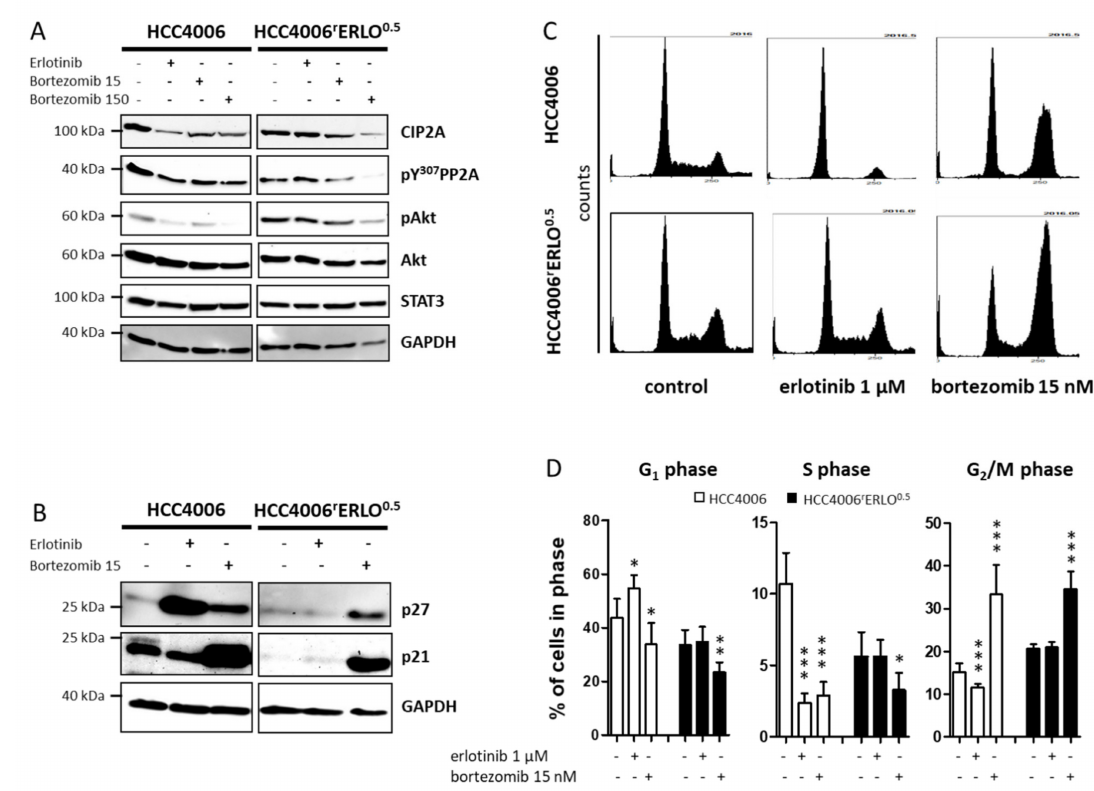
Figure 3. Bortezomib downmodulates cell proliferation regulating inhibitor of phosphatase 2A (CIP2A), restores regulation of Akt, and arrests cells in the G 2 /M phase of the cell cycle. Cells were incubated with 1 µ M erlotinib, 15 nM bortezomib ( A , B ) or 150 nM bortezomib ( A ) for 24 h. Proteins were separated on a 10% polyacrylamide gel and blotted on a nitrocellulose membrane, and specific target proteins were detected using target specific primary and species-specific secondary antibodies, coupled with horseradish peroxidase, as listed in the methods section. Signals were developed using a chemoluminescence substrate and detected with the ChemoCam System (Intas, Göttingen, Germany). A representative blot of at least three biological replicates is shown. ( C ) Distribution of the cell cycle phases was analyzed by propidium iodide staining of fixed cells and detection of the fluorescence intensities using a MACSQuant flow cytometer after incubating the cells with 1 µ M erlotinib or 15 nM bortezomib for 24 h. ( D ) The relative amount of cells in each phase of the cell cycle is displayed as mean ± SD, n = 6, * p < 0.05, *** p <